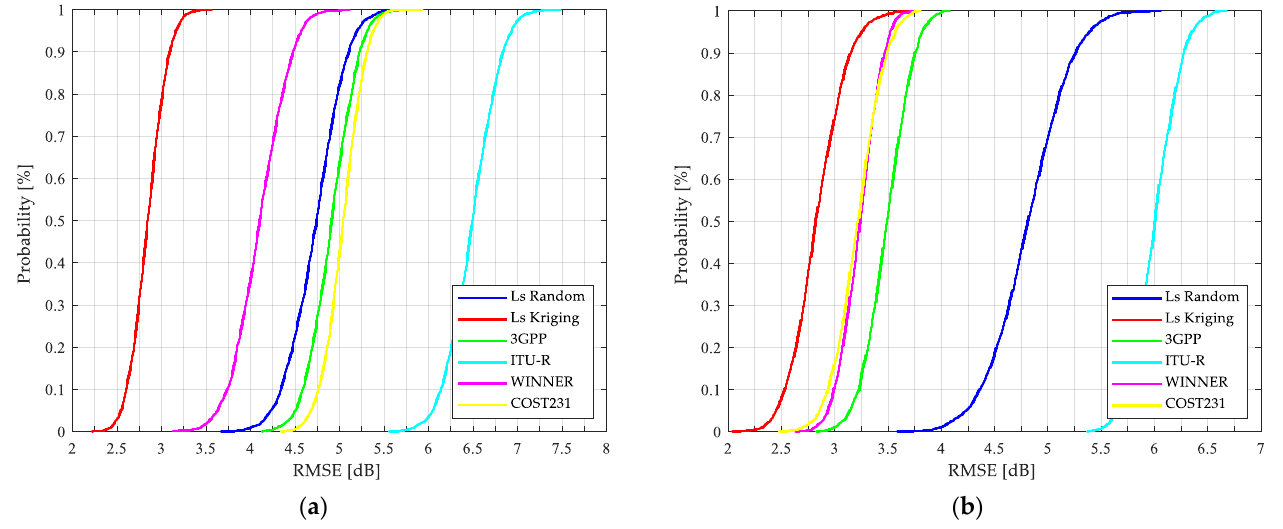
Figure 9. CDFs of RMSE for path loss predictions based on different models: ( a ) SS O2I links; ( b ) OS O2I